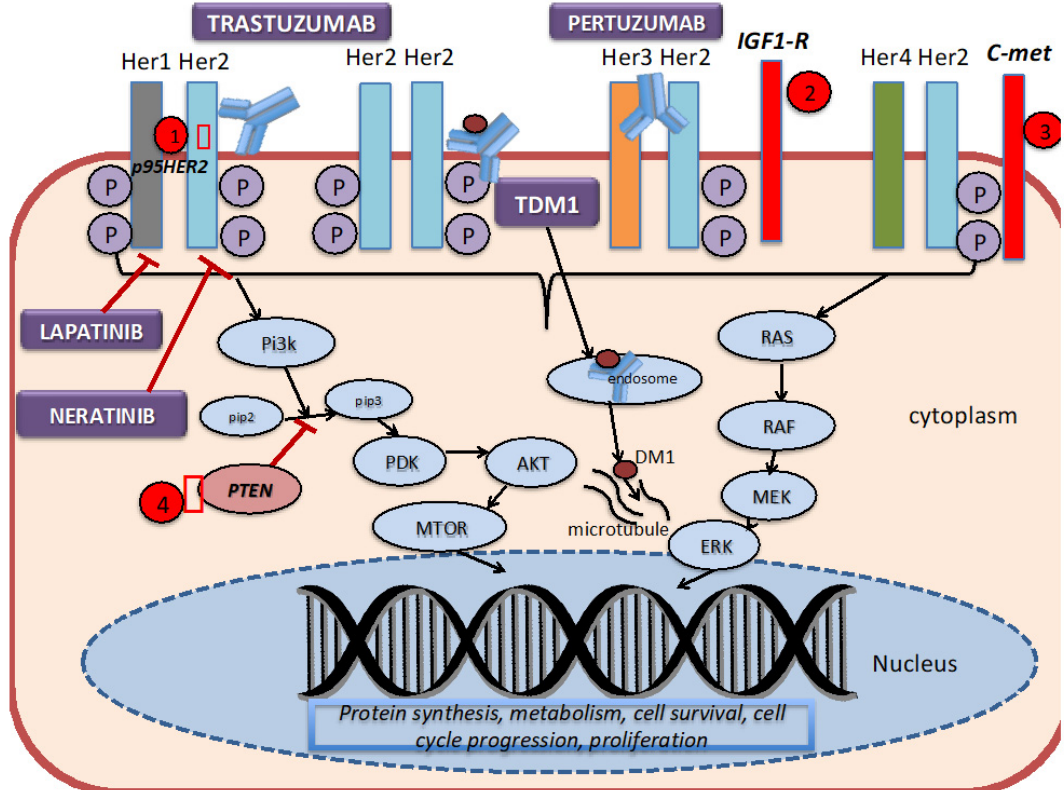
Figure 1. HER2 signaling pathway, mechanism of action of targeted therapies, and resistance mechanisms. 1. The truncated P95HER2 isoform results in the loss of the extracellular binding site for trastuzumab. 2.–3. Overexpression of other tyrosine kinase receptors, such as IGF1-R and C-met, can continue to trigger downstream signaling despite blockade by trastuzumab. 4. Mutations or loss of PTEN constitutively activates the PI3K signaling